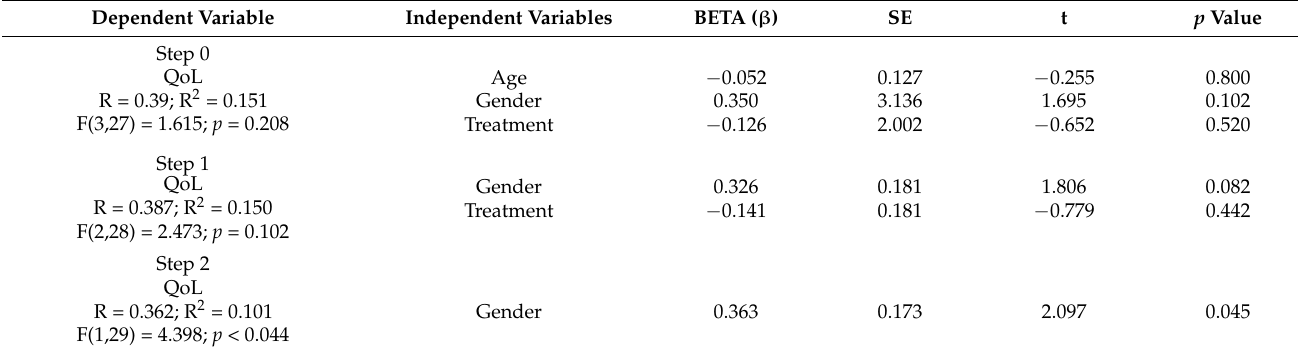
Table A1. Multivariate analysis of quality of life (QoL).